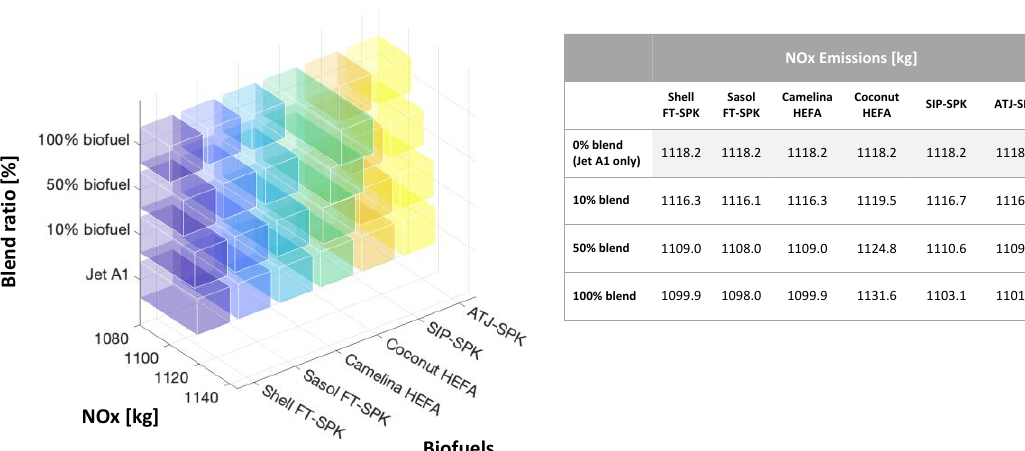
Figure 14. HC overall emissions along the reference Concorde mission, with the impact of different biofuels and blending ratios.